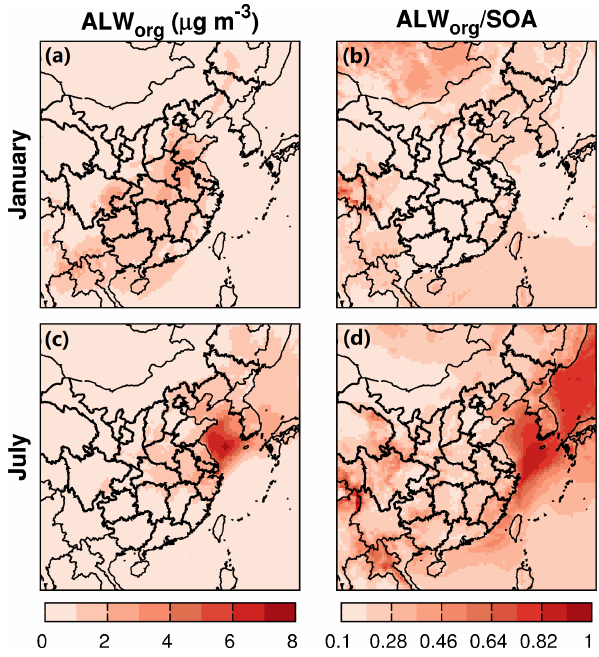
Figure 3. Monthly averaged water partitioning into the organic phase (ALW org , µgm − 3 ) and the ratio to SOA (ALW org / SOA) dur- ing January and July of